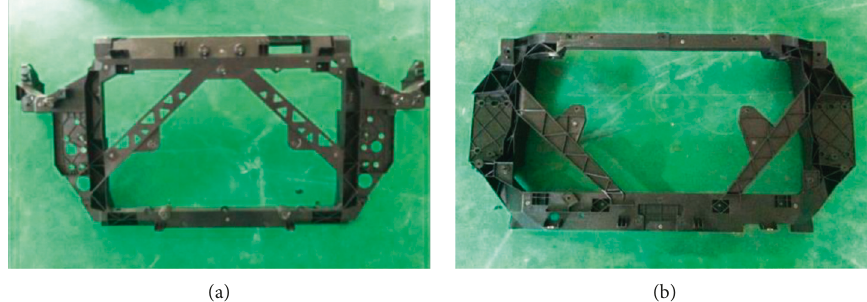
Figure 28: The state of the test piece after the resonance check test. (a) 1# (B-cross) test piece resonance check after test status; and (b) 2# (A2) test piece resonance check after the test state.